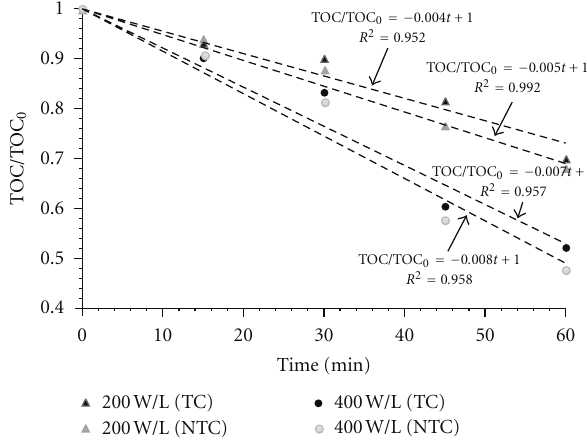
Figure 5: DCF degradation in terms of TOC in relation to ultra- sound power densities and bulk temperature conditions (20kHz, C = 0